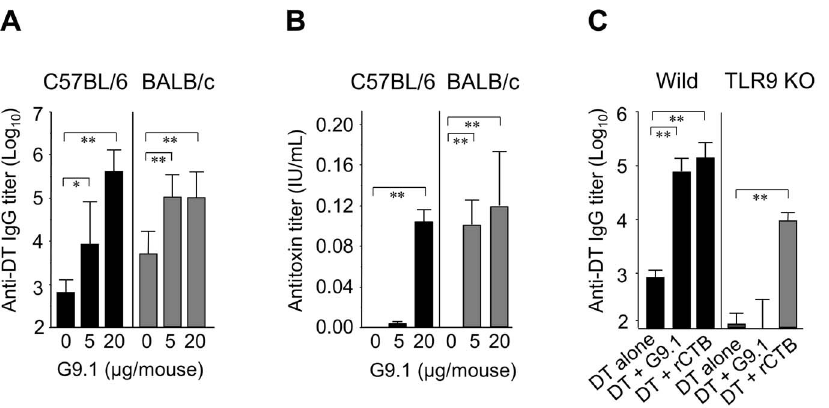
Figure 3. In the nasal vaccination system, G9.1 enhanced DT-specific TLR9-dependent IgG response and antitoxin activity. AandB , C57BL/6 and BALB/c mice were administered DT (2 Lf/mouse) plus G9.1 (0, 5, or 20 m g/mouse) nasally on days 0, 14, 21, and 28. Serum anti-DT IgG (A) and antitoxin (B) titers were measured in the blood samples collected from the tail on day 35. C , Wild-type C57BL/6 (Wild) and TLR9 KO mice were immunized with DT (2 Lf) alone, DT (2 Lf) plus G9.1 (20 m g), or DT (2 Lf) plus rCTB (10 m g), and serum anti-DT IgG titers measured as in A . * p , 0.05 and